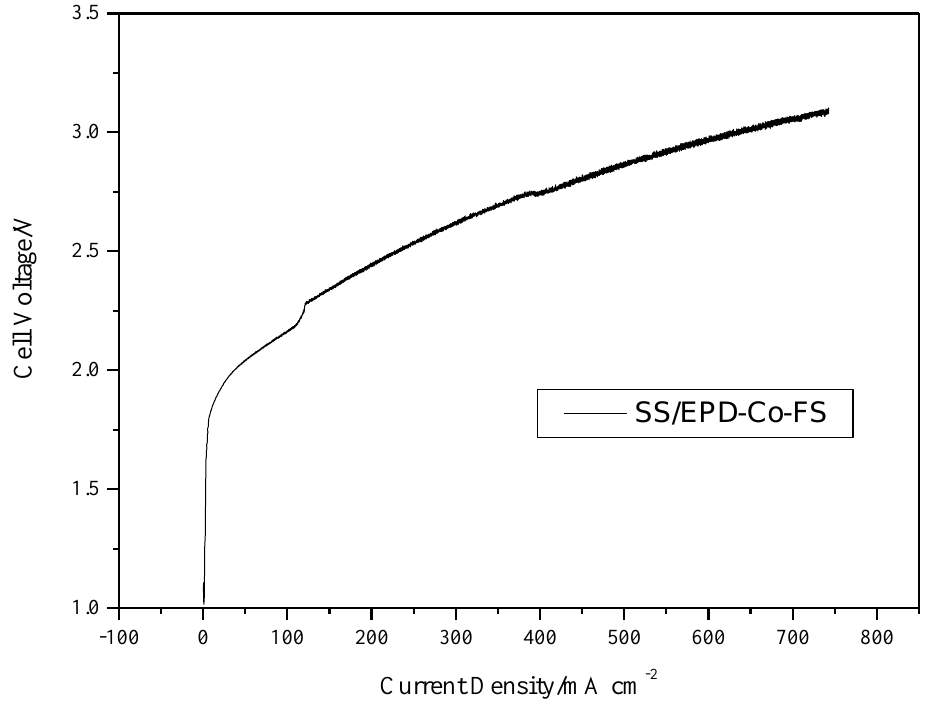
Figure 7. Cell voltage vs. current density for an electrolysis cell with SS/EPD-Co-FS, fed with KOH 0.5 M on the anode side at 100 mL min − 1 . Cell temperature 25 ◦